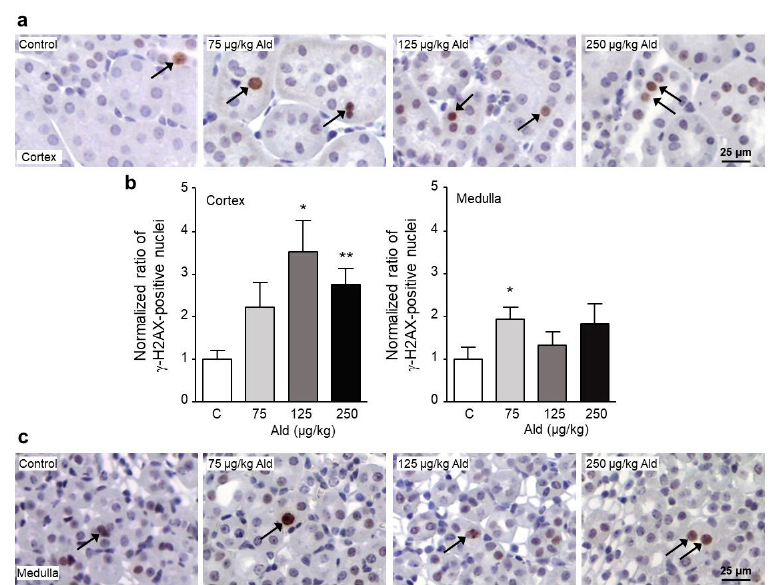
Figure 4. DNA damage caused by aldosterone infusion. Paraffin-embedded kidney sections were stained with an antibody against γ -H2AX, a marker of structural DNA damage. Staining of γ -H2AX in cortex ( a ) and medulla ( c ). ( b ) Quantification as ratio of γ -H2AX-positive stained nuclei normalized to the control. For the quantification of γ -H2AX-positive nuclei, 10 visual fields of cortical and five visual fields of medullary kidney sections were analyzed per animal via Image J. Examples of positive stained nuclei are marked with black arrows. γ -H2AX: phosphorylated histone 2AX, Ald: aldosterone. Data are shown as mean + SEM, n = 5. * p ≤ 0.05, ** p < 0.01 vs. C: control group.